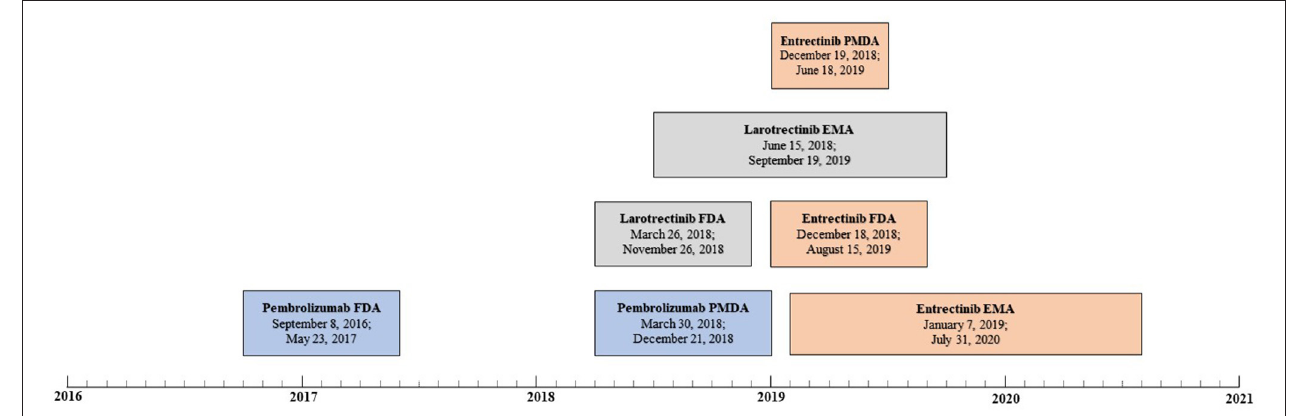
FIGURE 1 | Review timelines for medicinal products for tissue-agnostic indications per agency (pembrolizumab in blue, larotrectinib in gray, and entrectinib in orange). For each review, the submission date and approval data are displayed,